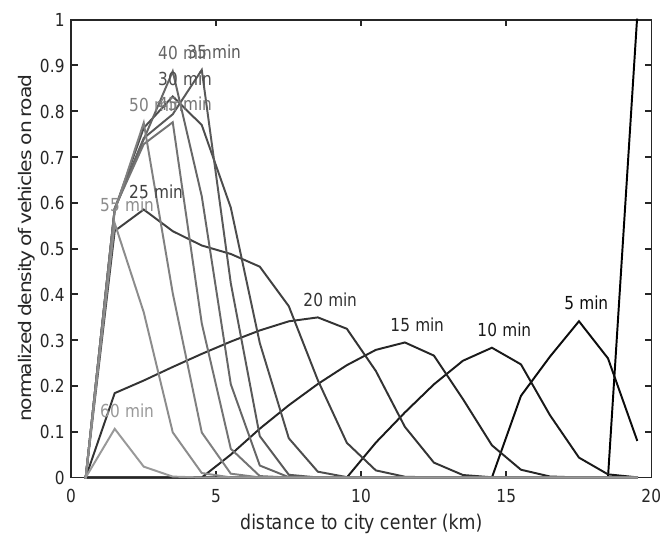
Figure 5. Normalized traffic density in terms of ρ max for different time steps. Traffic is directed towards city center. Note that the area decreases with decreasing distance to the